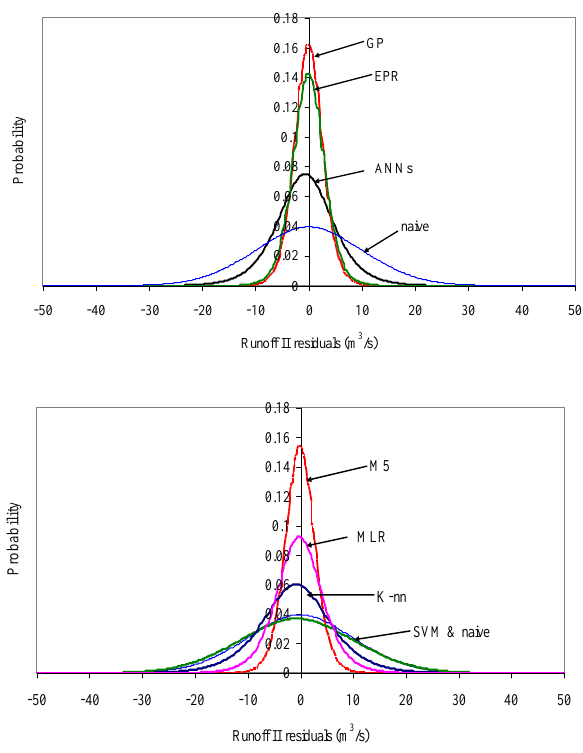
Fig. 12. Probability distribution of the 12 model residuals of all techniques (rainfall-runoff II case